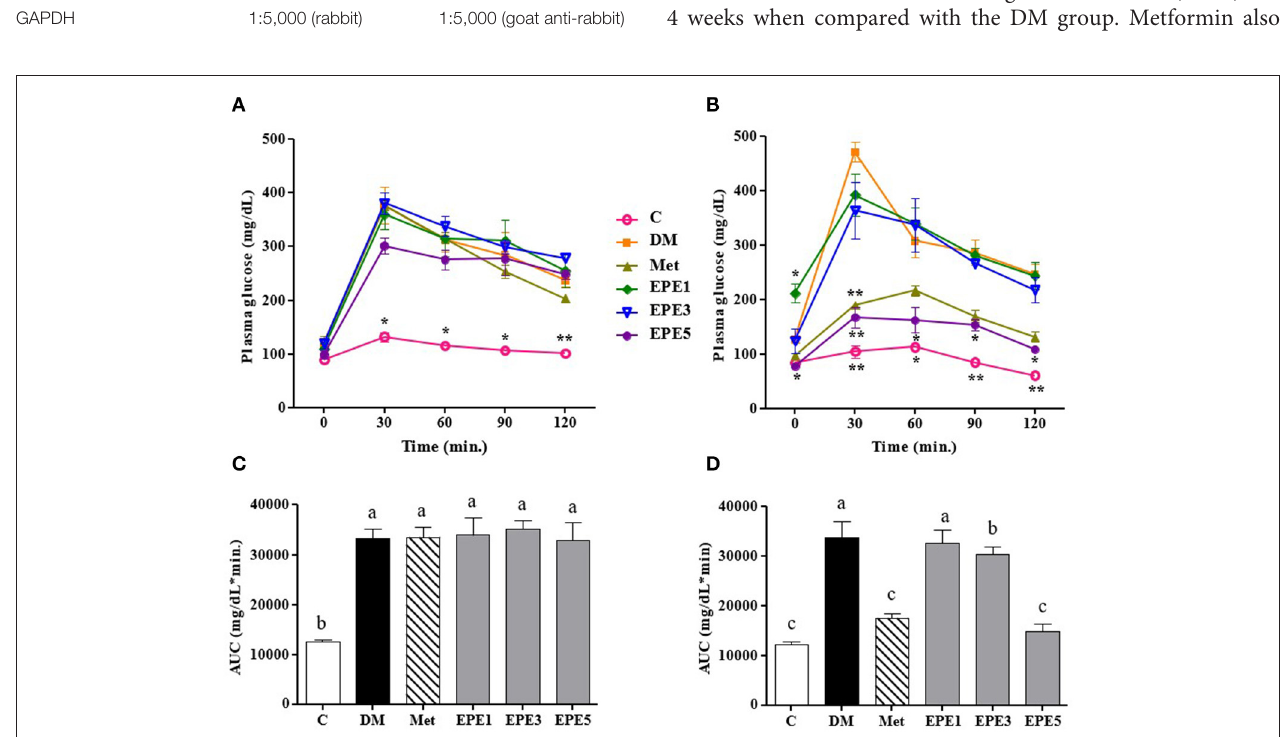
FIGURE 2 | The oral glucose tolerance test (OGTT): a week after streptozotocin (STZ)–nicotinamide (NA) injection or before treatment (A) and after treatment (B) and the area under the curve (AUC): before treatment (C) and after treatment (D) in diabetic rats. Data are shown as the mean ± SEM ( n = 6). Significant difference at * p < 0.05 and ** p < 0.01 vs. DM, respectively. The values with different superscript letters (a–c) represent significant differences ( p < 0.05) as analyzed by Duncan’s multiple range test. C, control; DM, diabetes mellitus; Met, metformin; EPE, Echinacea purpurea ethanol extract.